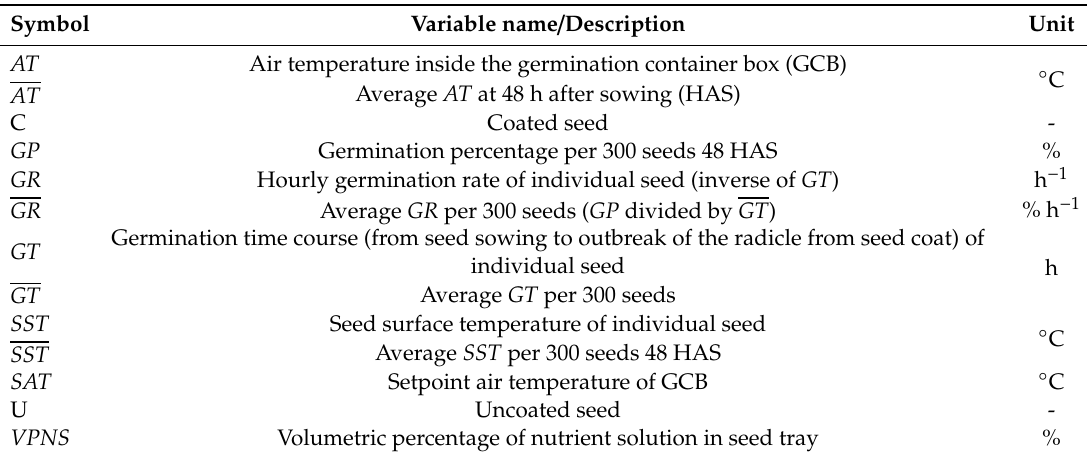
Table 1. List of symbols, variable names with descriptions and units.